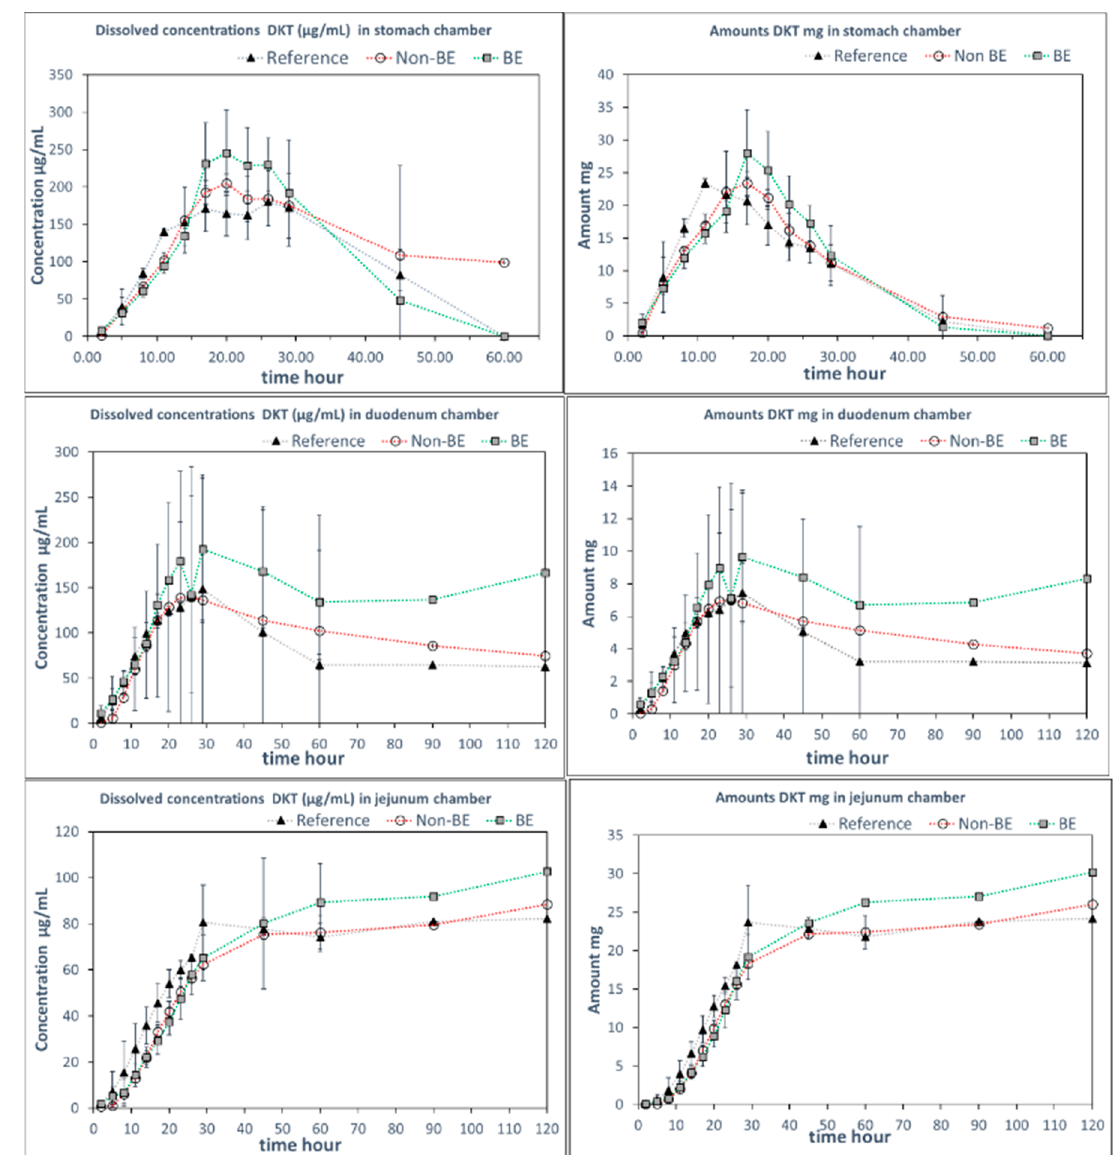
Figure 3. DKT concentrations ( left panels ) and amounts in solution ( right panels ) in the GIS stomach , GIS duodenum , and GIS jejunum vessels obtained with Protocol 1 with HCl 0.01M in GIS stomach and phosphate buffer 50 mM (pH 6.8) in the duodenal chamber (n = 3). Standard deviations overlap over the three profiles and they are not shown. Dotted lines are included to facilitate visual profile comparison.